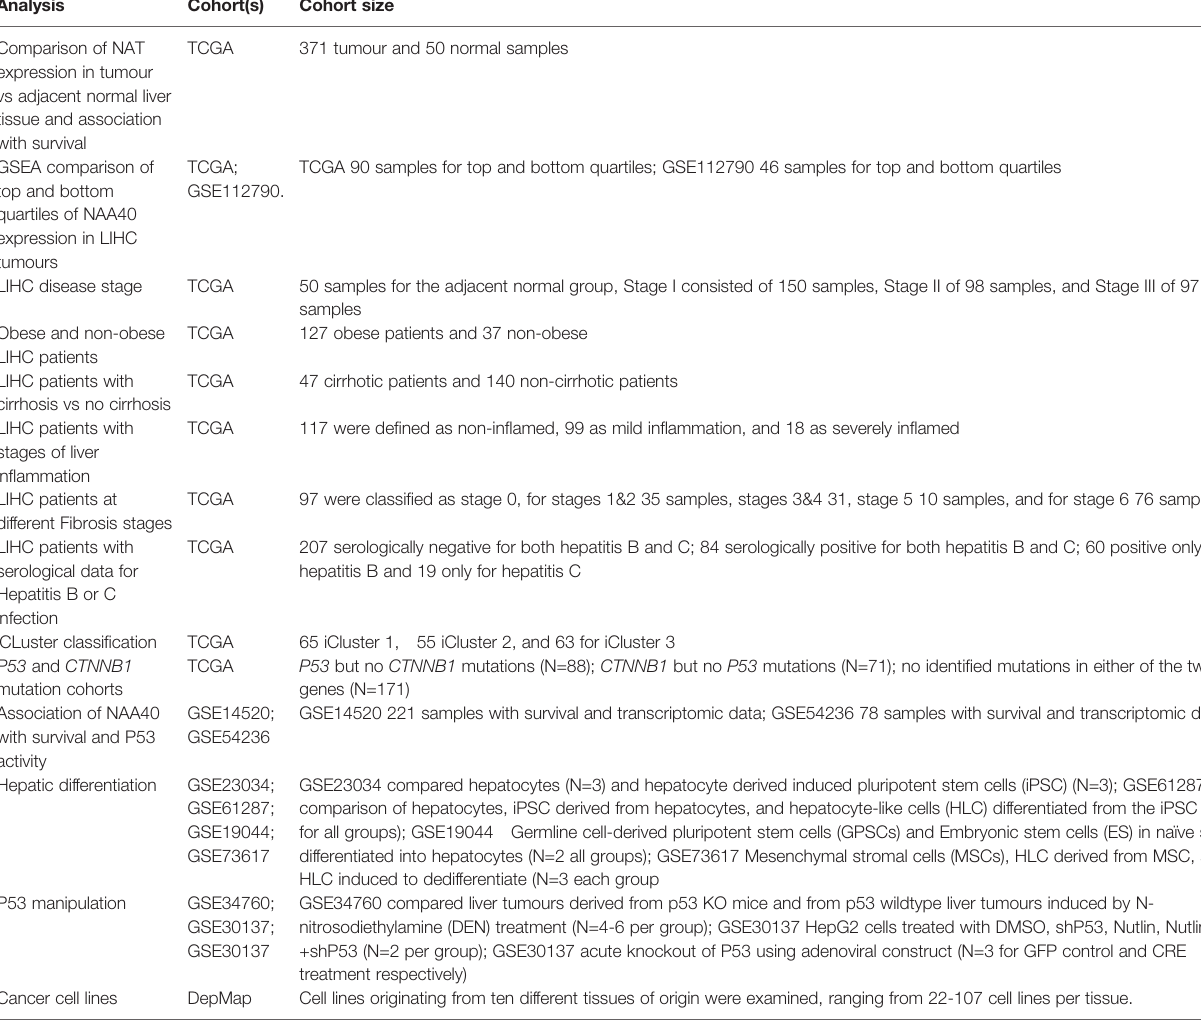
TABLE 1 | Information on studies examined as part of this study. Analysis Cohort(s) Cohort size Comparison of NAT expression in tumour